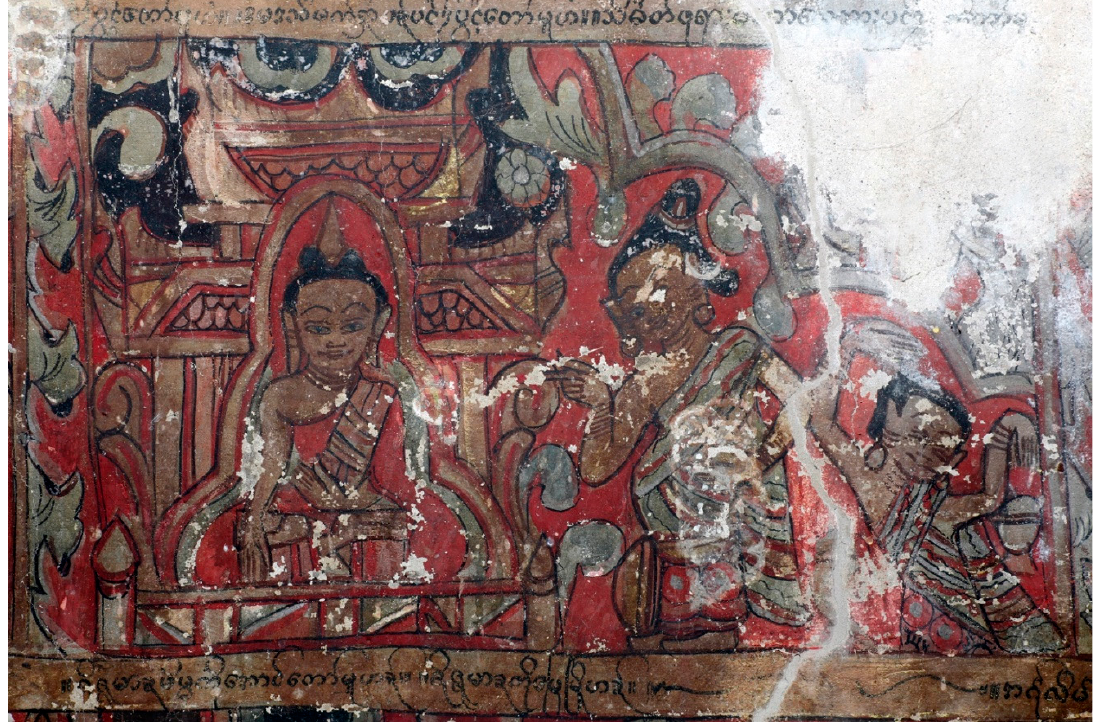
Figure 17. Salyingyi, 18th century. Punishment of Cinca, the bowl she used to fake her pregnancy on the ground, showing her next sinking into the ground.